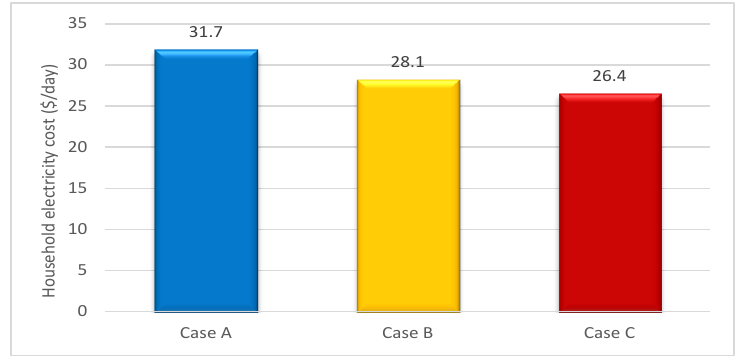
Figure 13. The daily electricity cost of the household in three